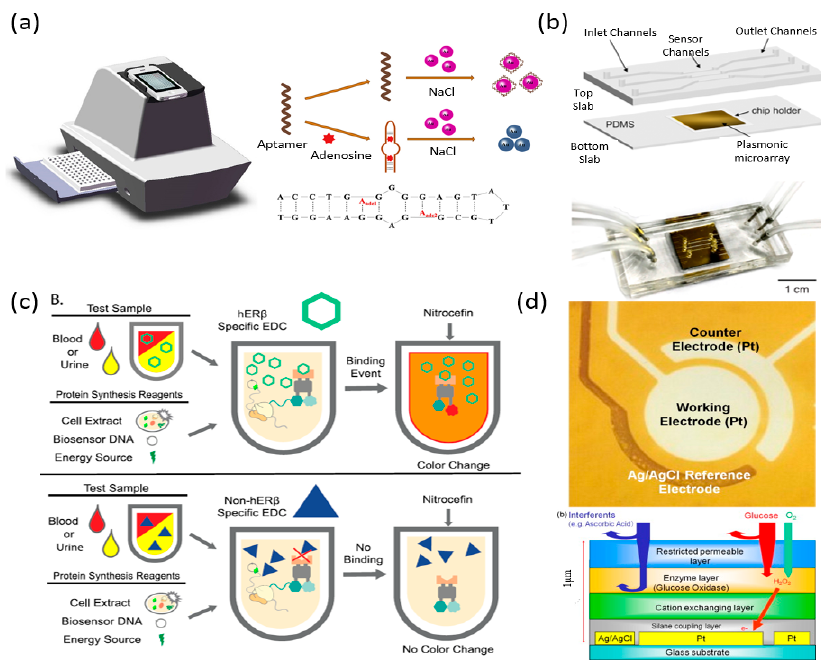
Figure 4. Portable biosensors for urine Biomarker biosensors detection. ( a ) The schematic of the bionic electronic-eye (E-eye) and the sensing mechanism of the colorimetric aptasensor for adenosine detection [35]. ( b ) Schematic and image of Soler’s Chlamydia trachomatis (CT) and Neisseria gonorrhoeae (NG) biosensor integrated with a microfluidic system [36]. ( c ) The RAPID biosensor assay. The presence of estrogen hER β -specific ligands in the sample triggers a color change in the assay, which can be observed visually or more accurately measured using a spectrometer [38]. ( d ) Glucose sensor construction showing the Electrodes layout in H 2 O 2 sensor and a Cross-sectional schematic of the sensor [39].